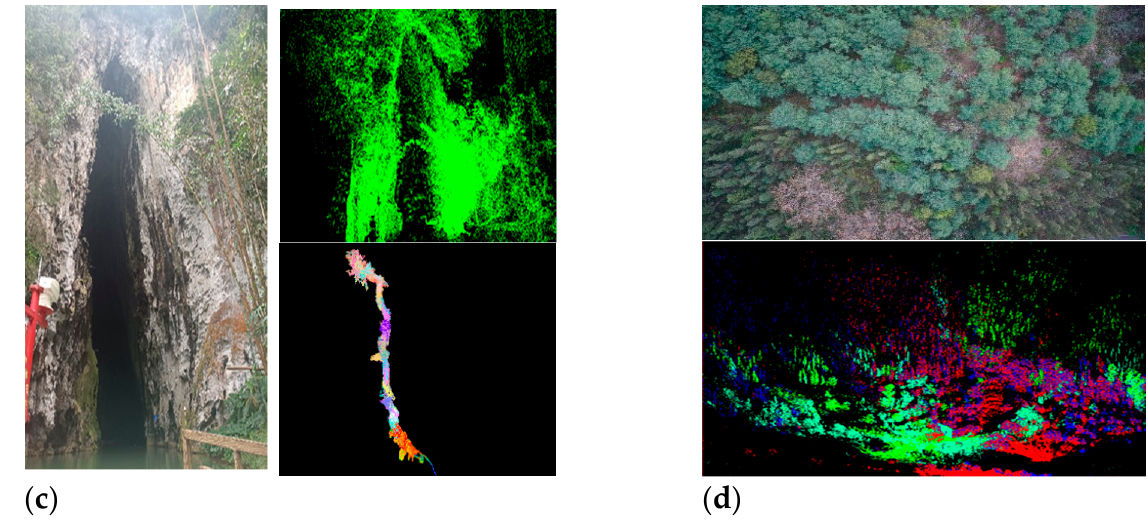
Figure 6. Point cloud dataset used for the experiment. ( a ) WHU-TLS Mountain dataset of Wuhan University; ( b ) Point cloud data of the Cliff Wall in Huidong County, Sichuan Province; ( c ) Point cloud data of Tangna karst cave, Bamei Town, Yunnan Province; ( d ) Point cloud data of Haikou Forest, Kunming City, Yunnan Province. Table 2. Description of experimental data. Point Cloud Data Scan Point Numbers